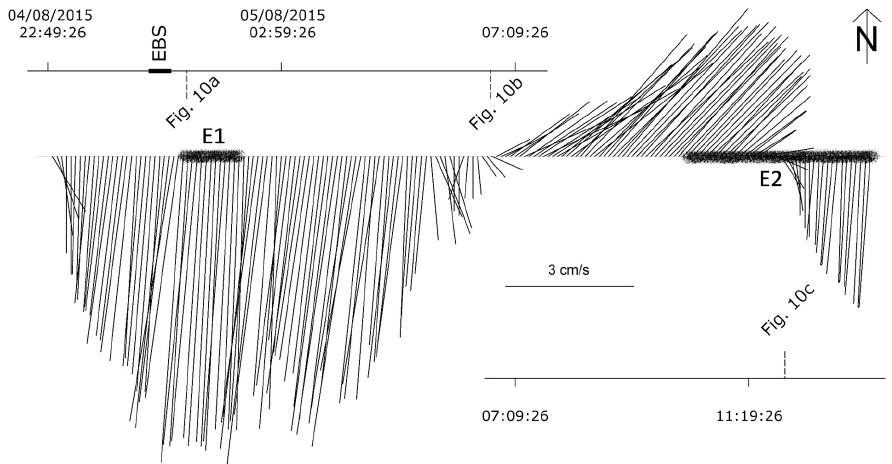
Figure 9. Feather plot of the prevailing currents before, during, and after EBS erosion window (thick line) recorded by the downward-looking ADCP in the BoBo lander. The E1 and E2 events measured by the sensors on the BoBo lander are indicated as textured areas in grey. The dashed lines indicate the time snaps of the model simulation (2 µm class) shown in Figure 10.